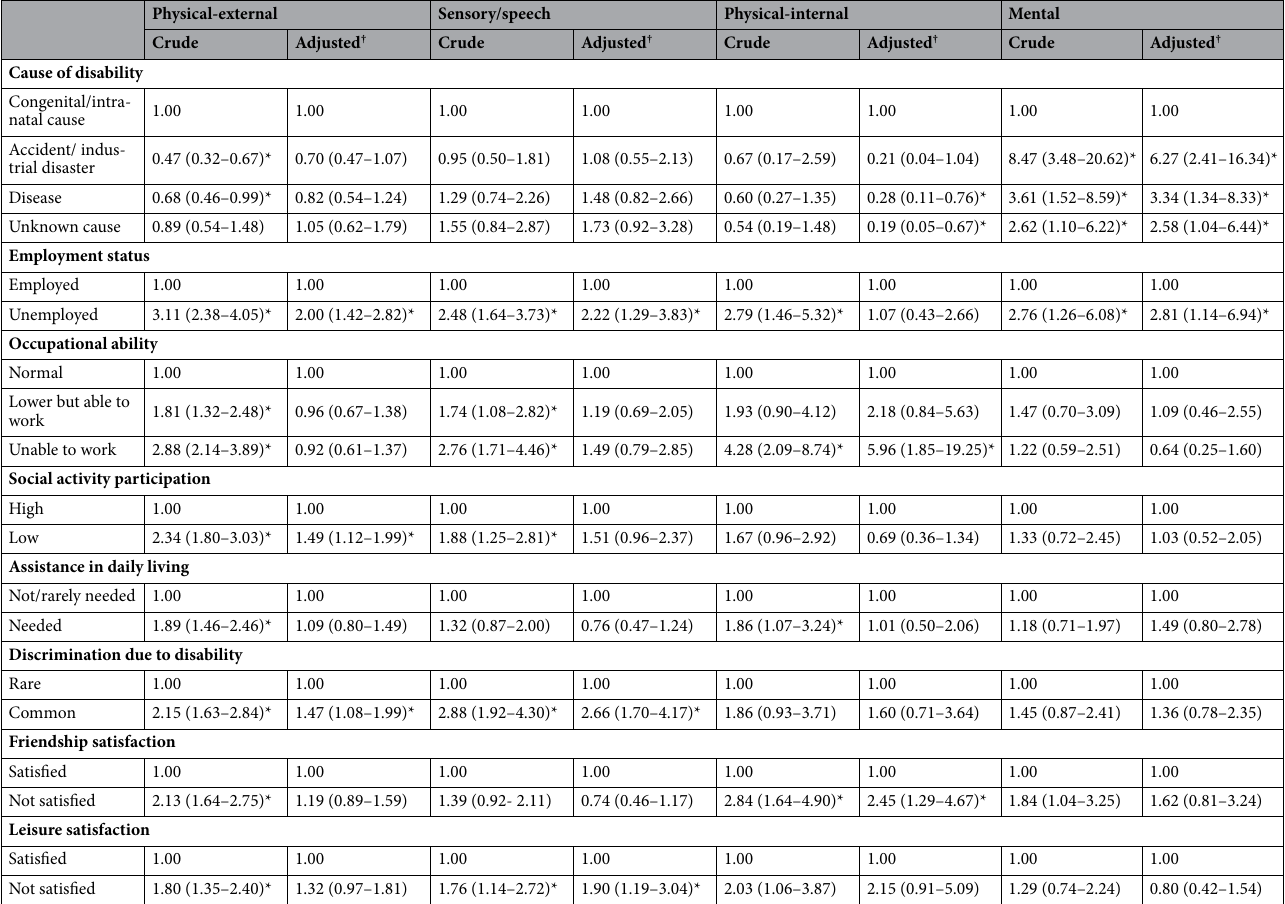
Table 3. Stratification analysis of two-year follow up of crude and adjusted hazard ratios (95% CI) for depressive symptoms by four types of disability. † Adjusted for type of disability, cause of disability, gender, age, marital status, household income, household size, area of residence, employment status, occupational ability, social activity participation, assistance in daily living, discrimination due to disability, friendship satisfaction, leisure satisfaction, chronic conditions, and smoking. During each stratification analysis, factors that were stratified for were not included in the